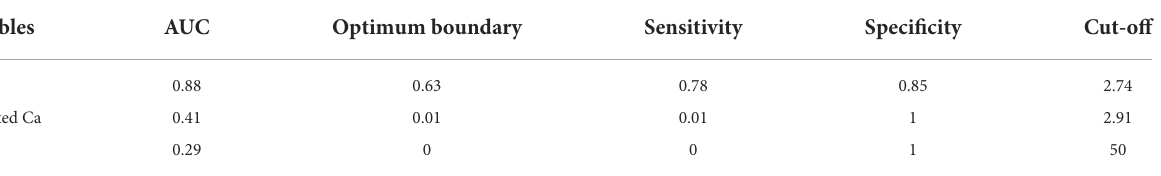
TABLE 7 Results of ROC best